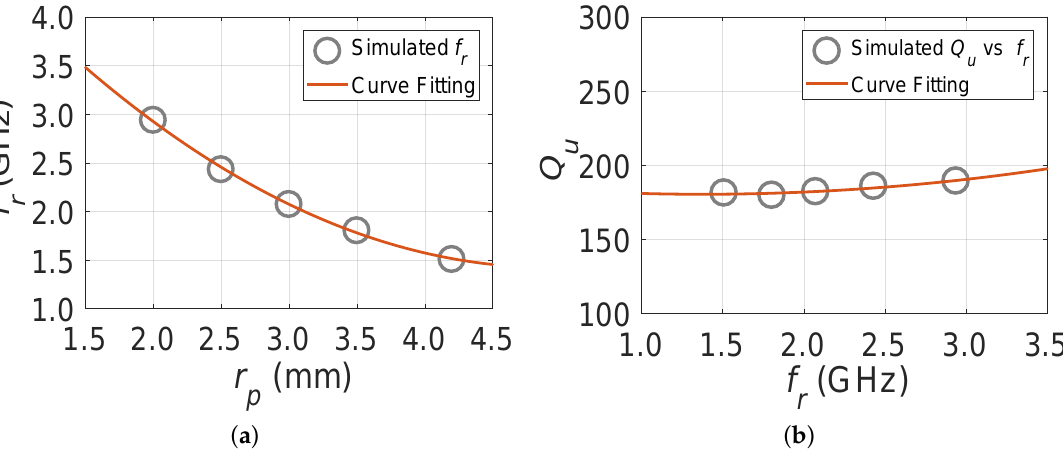
Figure 4. ( a ) Resonant frequency f r versus circular disk plate radius r p ; ( b ) Resonator Q u versus f r for the same variation of r p of ( a